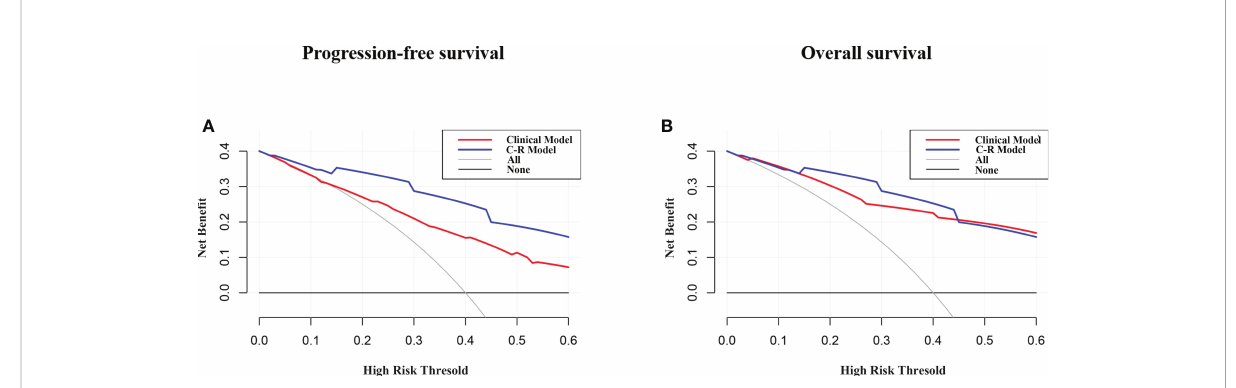
FIGURE 6 DCA of PFS (A) and OS (B) for the model. The y-axis measures the net bene fi t. The net bene fi t was calculated by summing the bene fi ts (true positive results) and subtracting the harms (false-positive results), weighting the latter by a factor related to the relative harm of undetected cancer compared with the harm of unnecessary treatment. The C-R model had the highest net bene fi t compared with the clinical